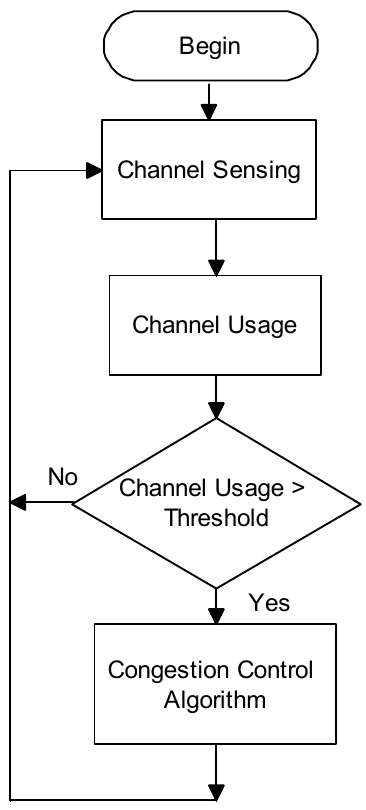
Figure 3. Congestion Control Mechanism.